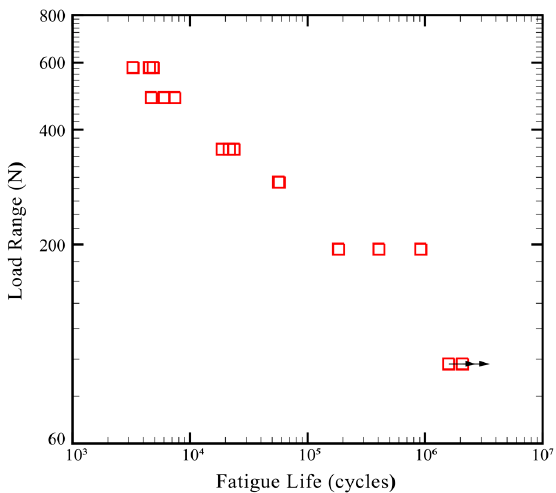
Figure 13. Fatigue test results of clinch joints in CT specimens made by Punch P1 and Die D1 under a punching force of 69 kN, Heat Mode B, and a heating temperature of 100 ◦